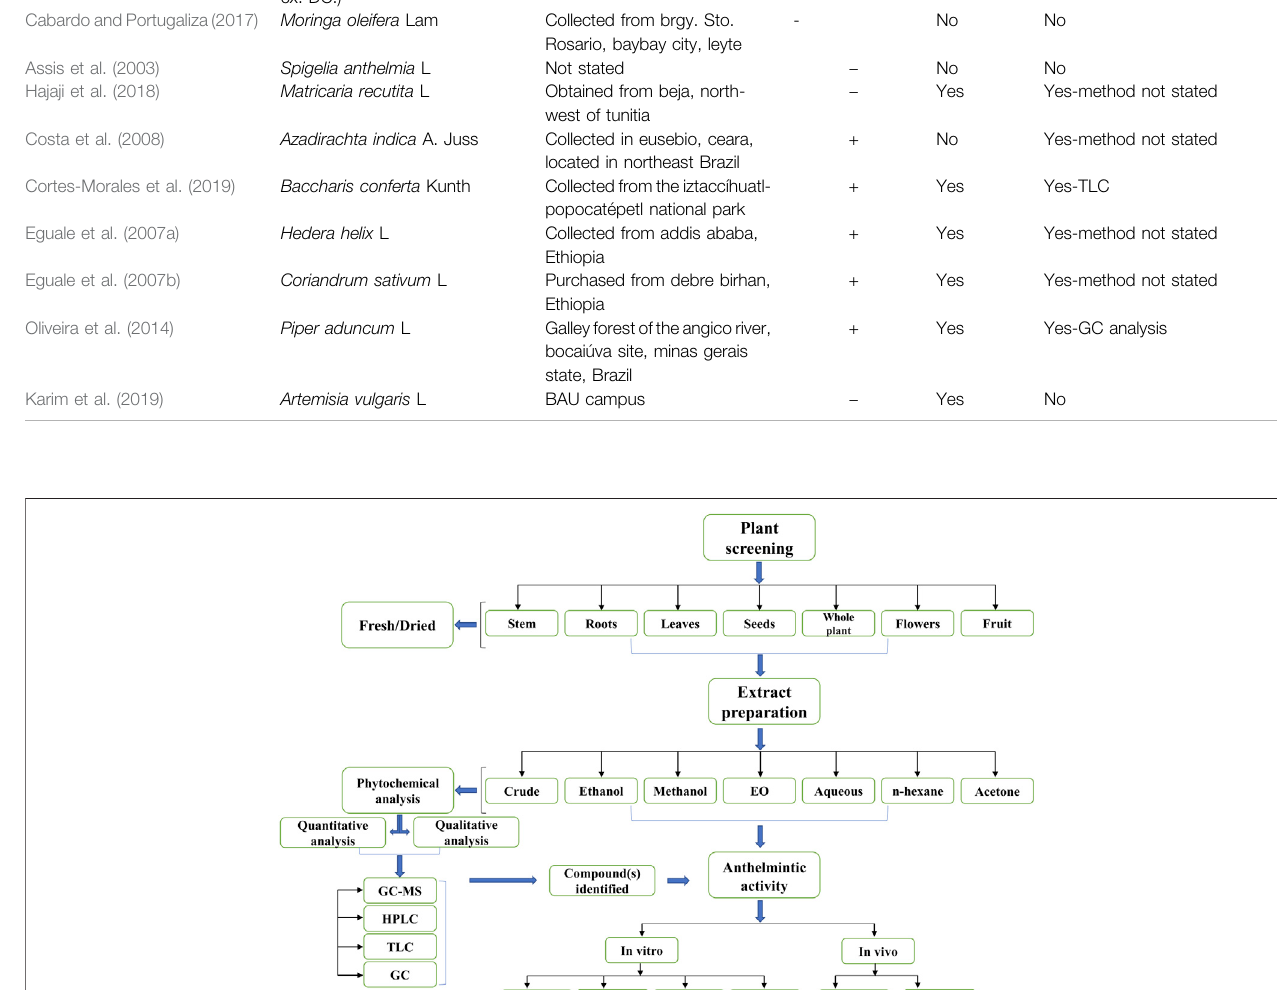
Frontiers in Pharmacology |